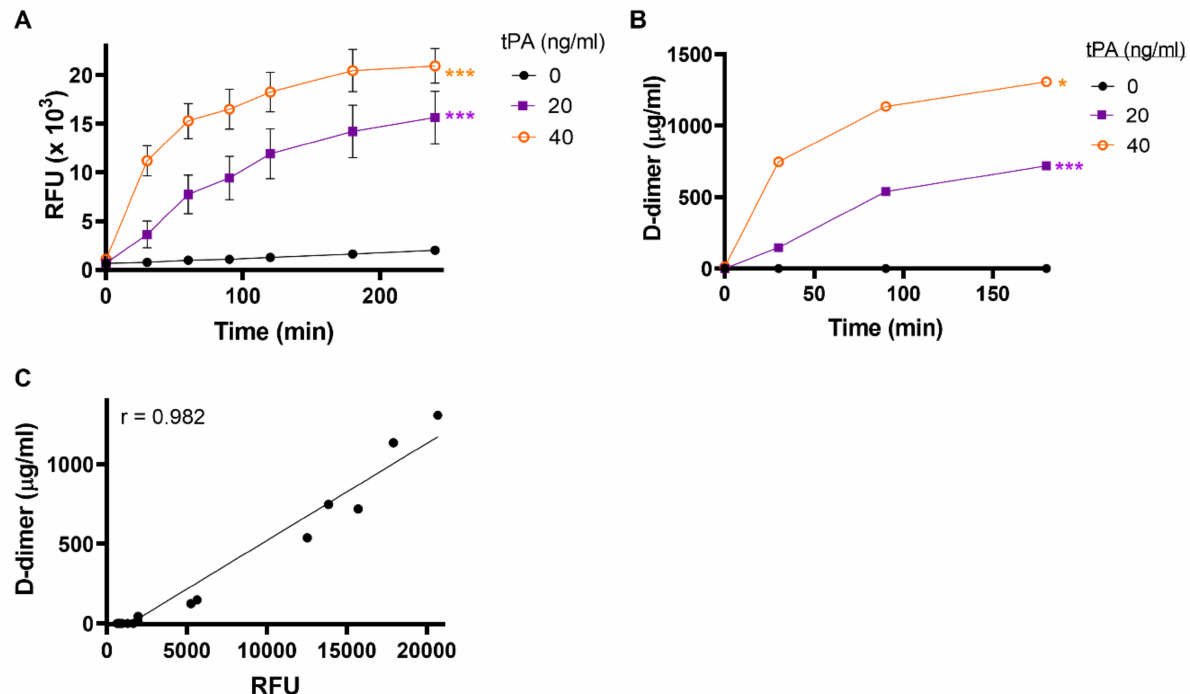
Figure 1. Dose-dependent thrombolysis with endogenous levels of tPA. Whole-blood model thrombi containing FITC- fibrinogen were formed by rotation for 30 min in the presence or absence of 20 or 40 ng/mL added tissue-type plasminogen activator (tPA). ( A ) Fibrinolysis was measured as relative fluorescence release (RFU) over 4 h in the bathing fluid. ( B ) D-dimer levels were measured in the bathing fluid and ( C ) correlated with FITC results (R = 0.96). Data shown are mean ± SEM, n ≥ 3. *** p < 0.001 vs. no